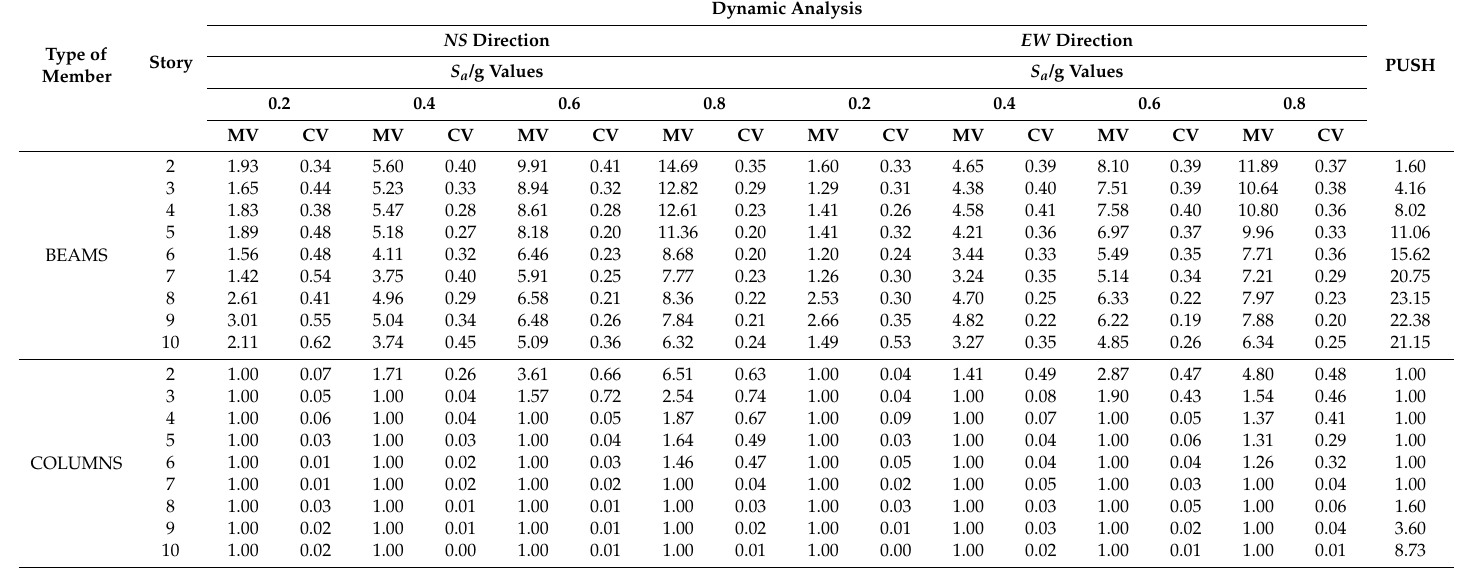
Table 4. Statistics for µ L φ , 10-level